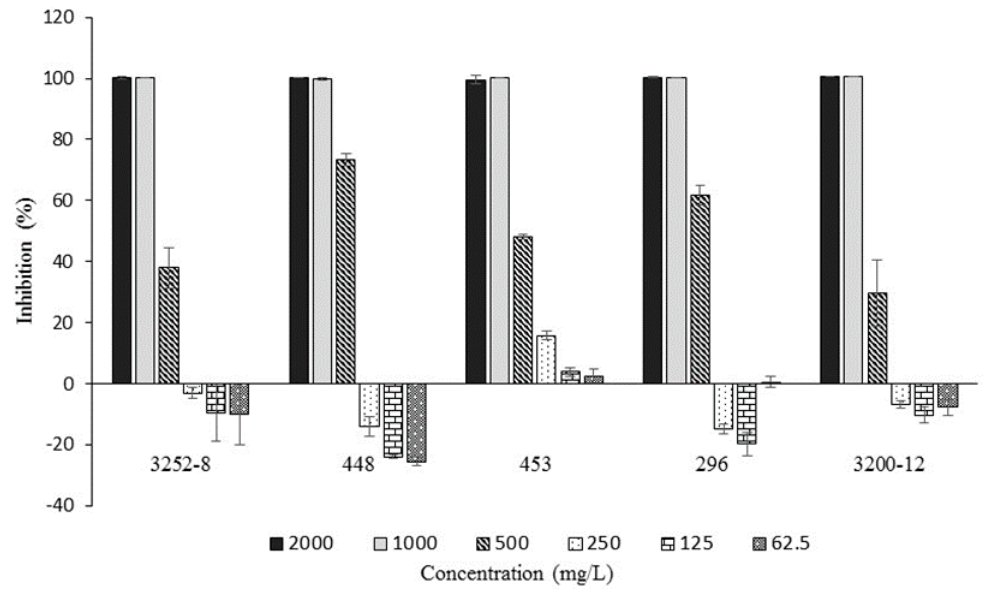
Figure 4. Growth inhibition of di ff erent B. glumae strains produced by di ff erent concentrations of 3-phenylpropanoic